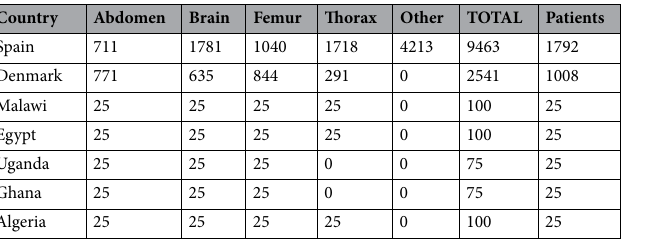
Table 2. Number of subjects for each of the four datasets used during the training, validation and testing phases.